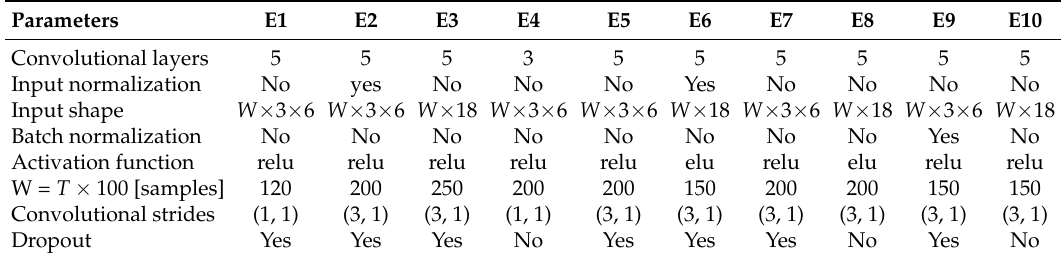
Table A2. Final hyper-parameters for the repetition counting models.